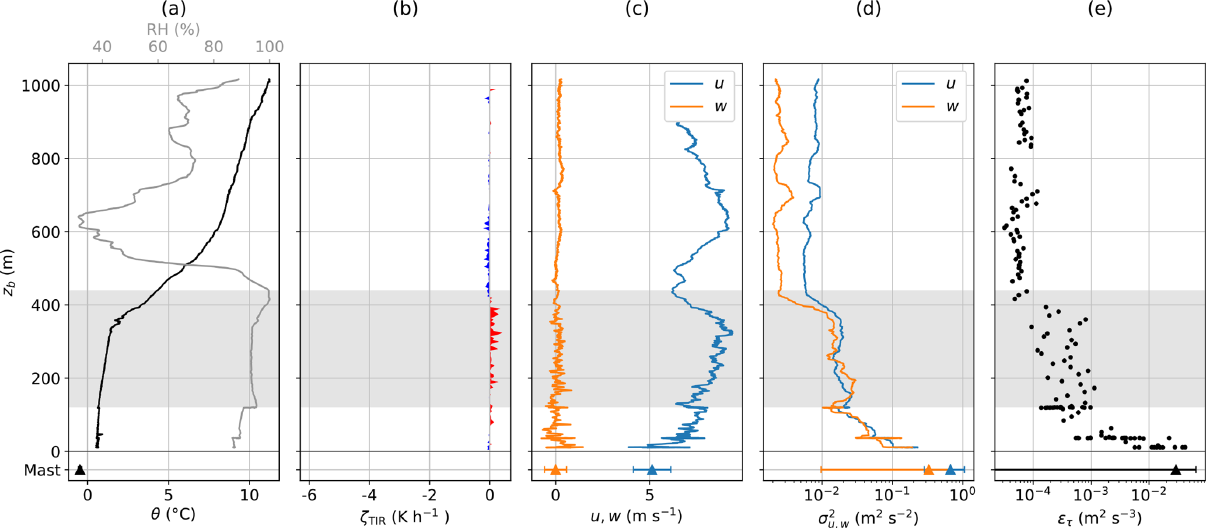
Figure 13. Same as Fig. 10, but for an ascent on 14 June 2017. No constant altitude segments were recorded.